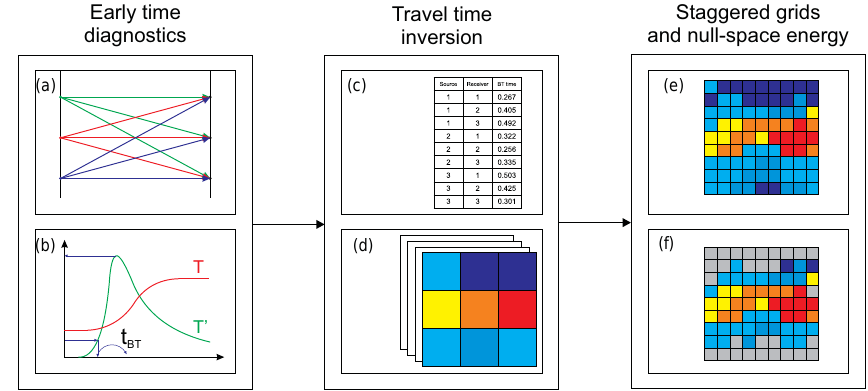
Figure 2. Major steps of inversion methodology: (a) conceptual setup of thermal tracer tomography, (b) breakthrough time detection using the early arrival times, (c) tomographic breakthrough time data set, (d) inverted tomograms applying the eikonal solver on different shifted grids, (e) high-resolution tomogram after merging the staggered results together and (f) non-reliable pixels masked after null-space energy